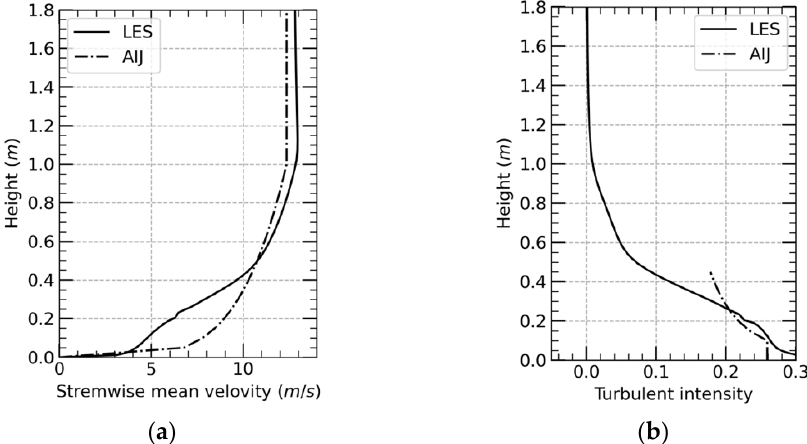
Figure 5. ( a ) The streamwise mean velocity profile and ( b ) the turbulence intensity profiles within the target area using virtual roughness blocks, AIJ profiles are plotted as reference.